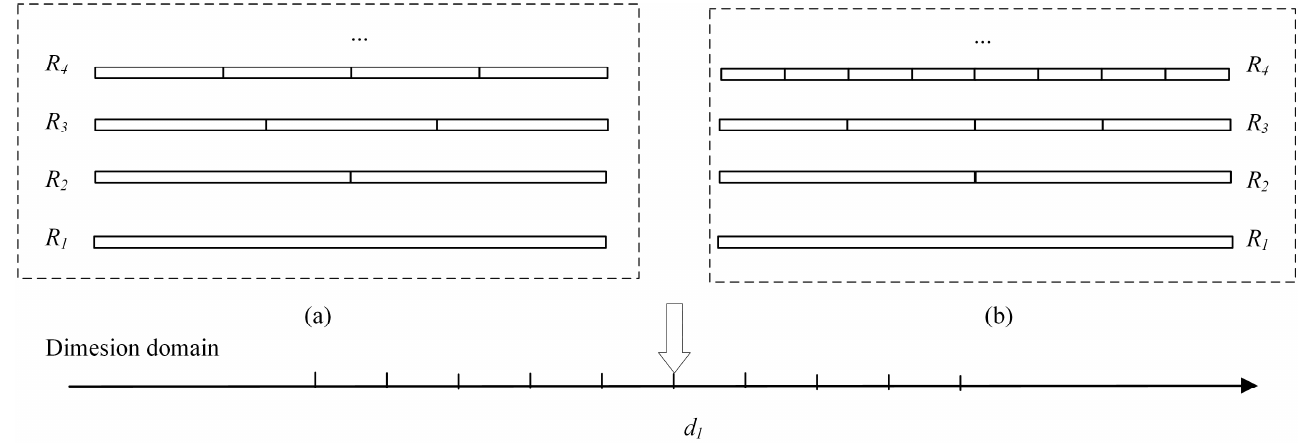
Figure 2. Different representations of points on dimension domains. ( a ) d 1 is represented as one index value at R 1 granularity, two index values at R 2 granularity, and three index values at R 3 granularity, respectively. ( b ) d 1 is represented as one index value at R 1 granularity, two index values at R 2 granularity, and four index values at R 3 granularity.